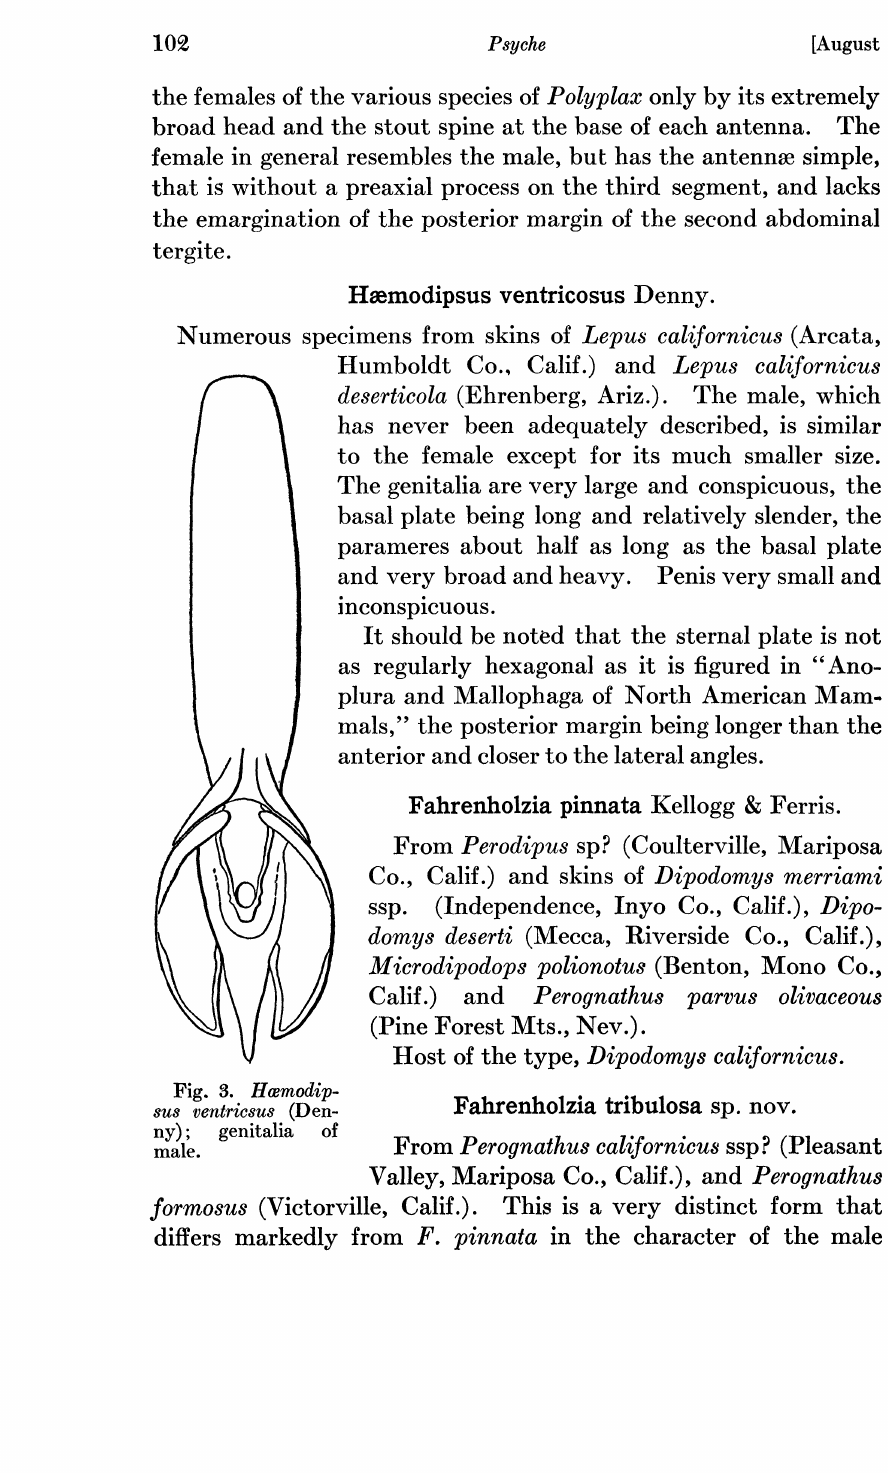
Fig. 3. Hamodip- sus ventricsus (Den- Fahrenholzia ribulosa sp. nov. ny)" genitalia of